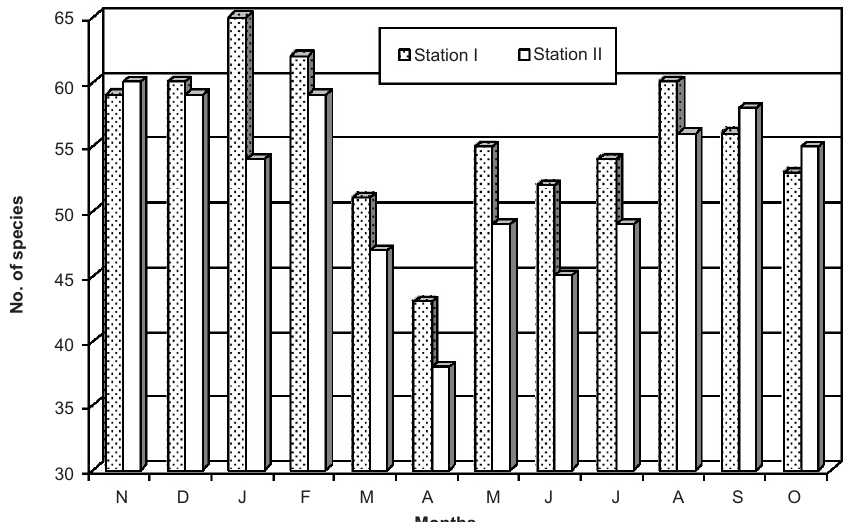
Figure 1. Monthly variations in richness of